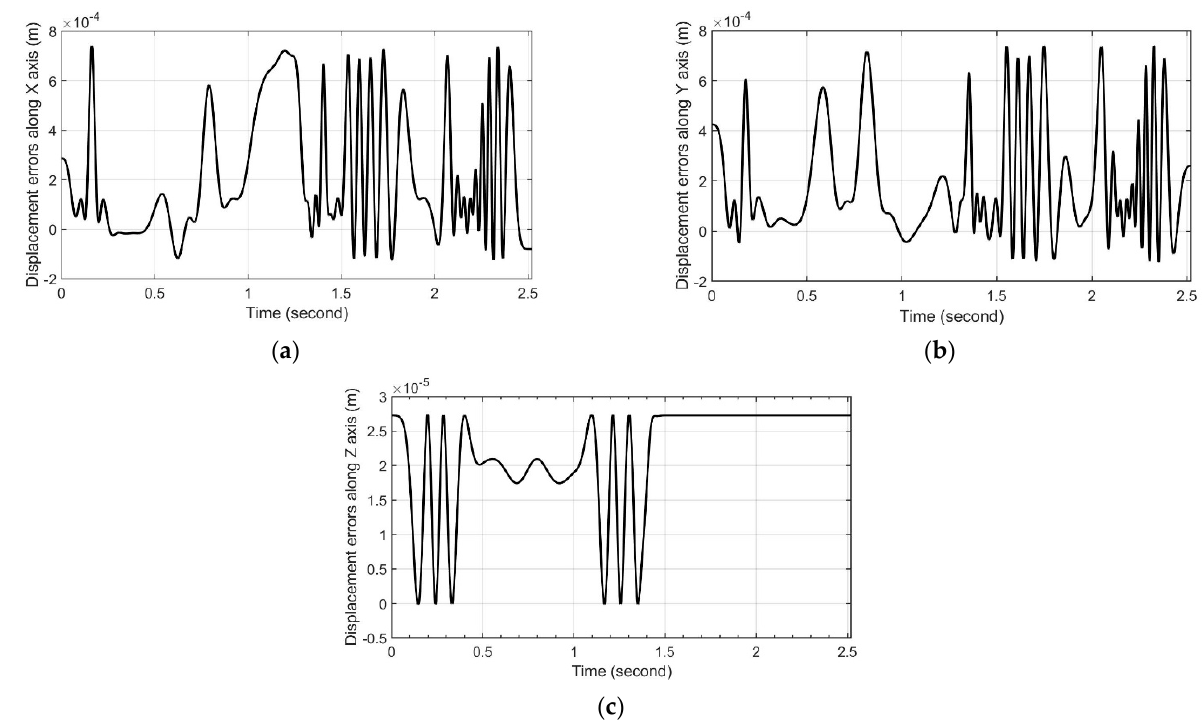
Figure 12. Displacement errors along ( a ) x axis ( b ) y axis ( c ) z axis.